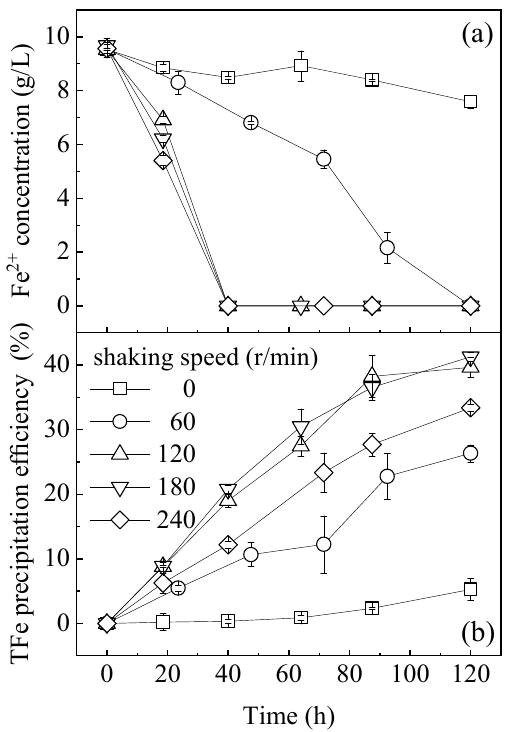
Figure 2. Effect of hydraulic shear force on the ( a ) Fe 2+ concentration and ( b ) TFe precipitation efficiency in the 9K-FeSO 4 - A. ferrooxidans system.